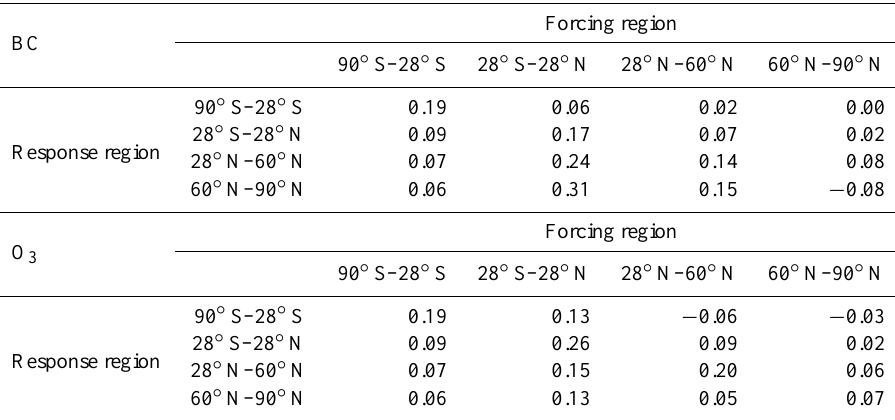
Fig. 1. GTP(20) for emissions of SO 2 , POM and BC from the four HTAP continents. Error bars reflect 1s.d. uncertainty in the multi-model responses. Table 3. Regional response coefficients in K(Wm − 2 ) − 1 for unit forcing from changes in BC and O 3 . Values are taken from Fig. 1 of Shindell and Faluvegi (2009). Data from CO 2 changes are used for the 90 ◦ S–28 ◦ S forcing region. The k lm coefficients used in section 4 are derived by normalising these values by the climate